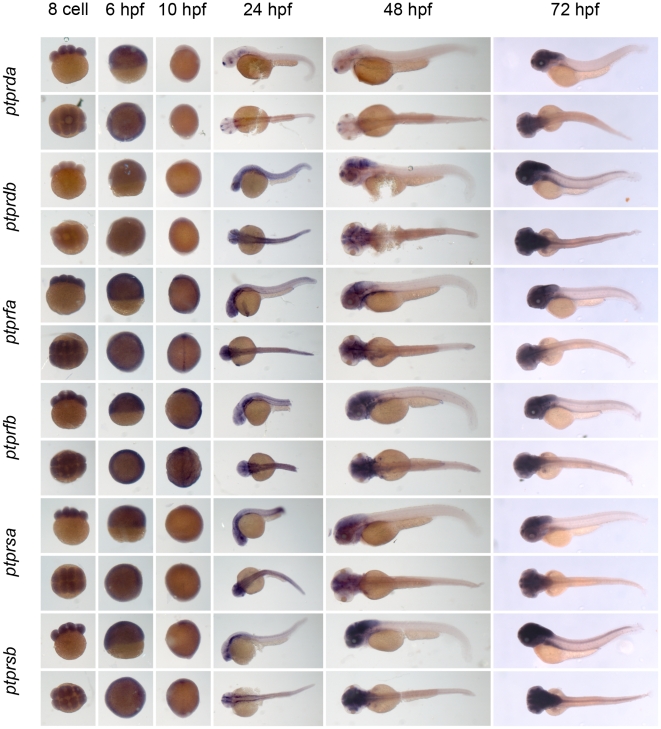
See legend to Fig. 3.